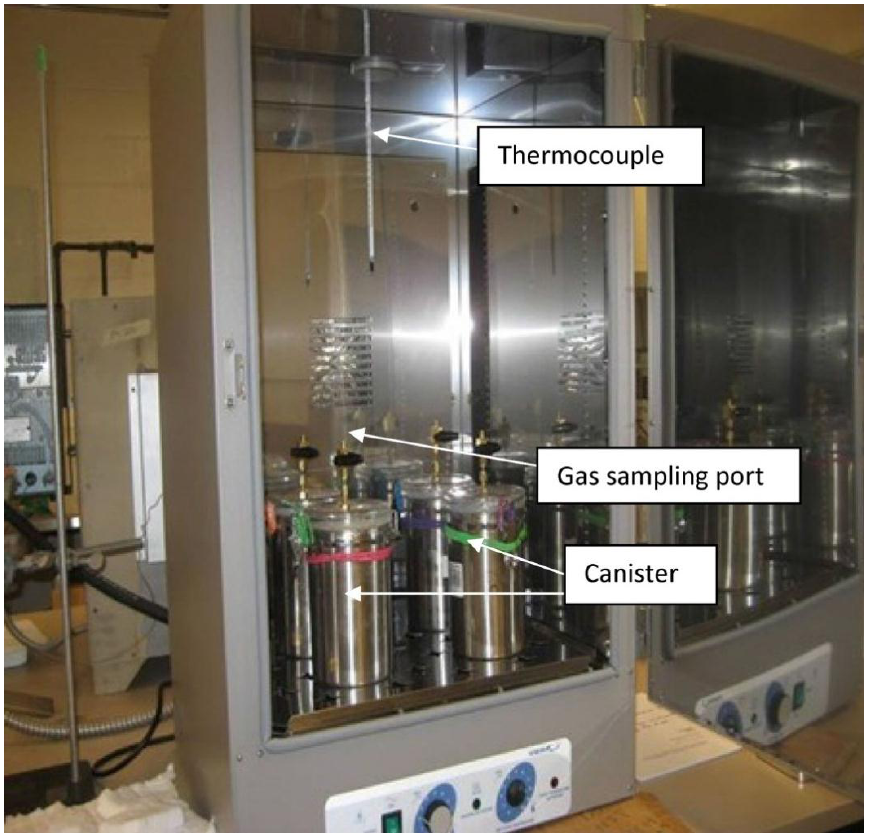
Figure 1. Storage canisters filled with different